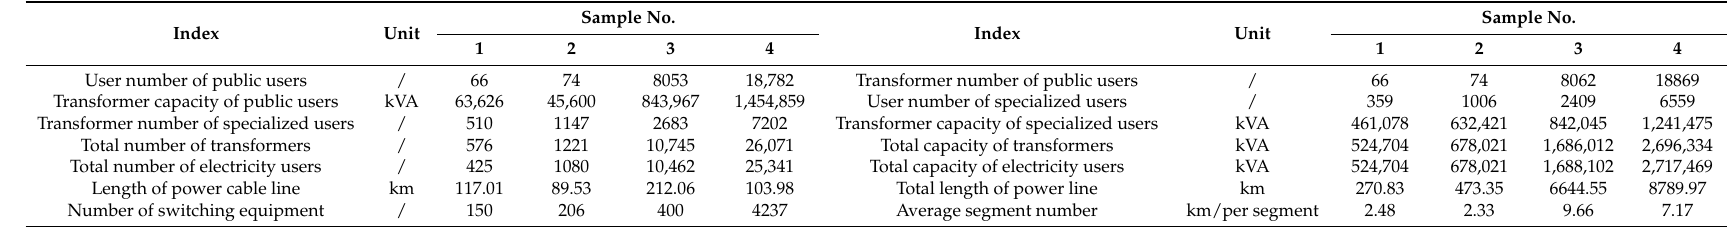
Table A2. Original data of typical